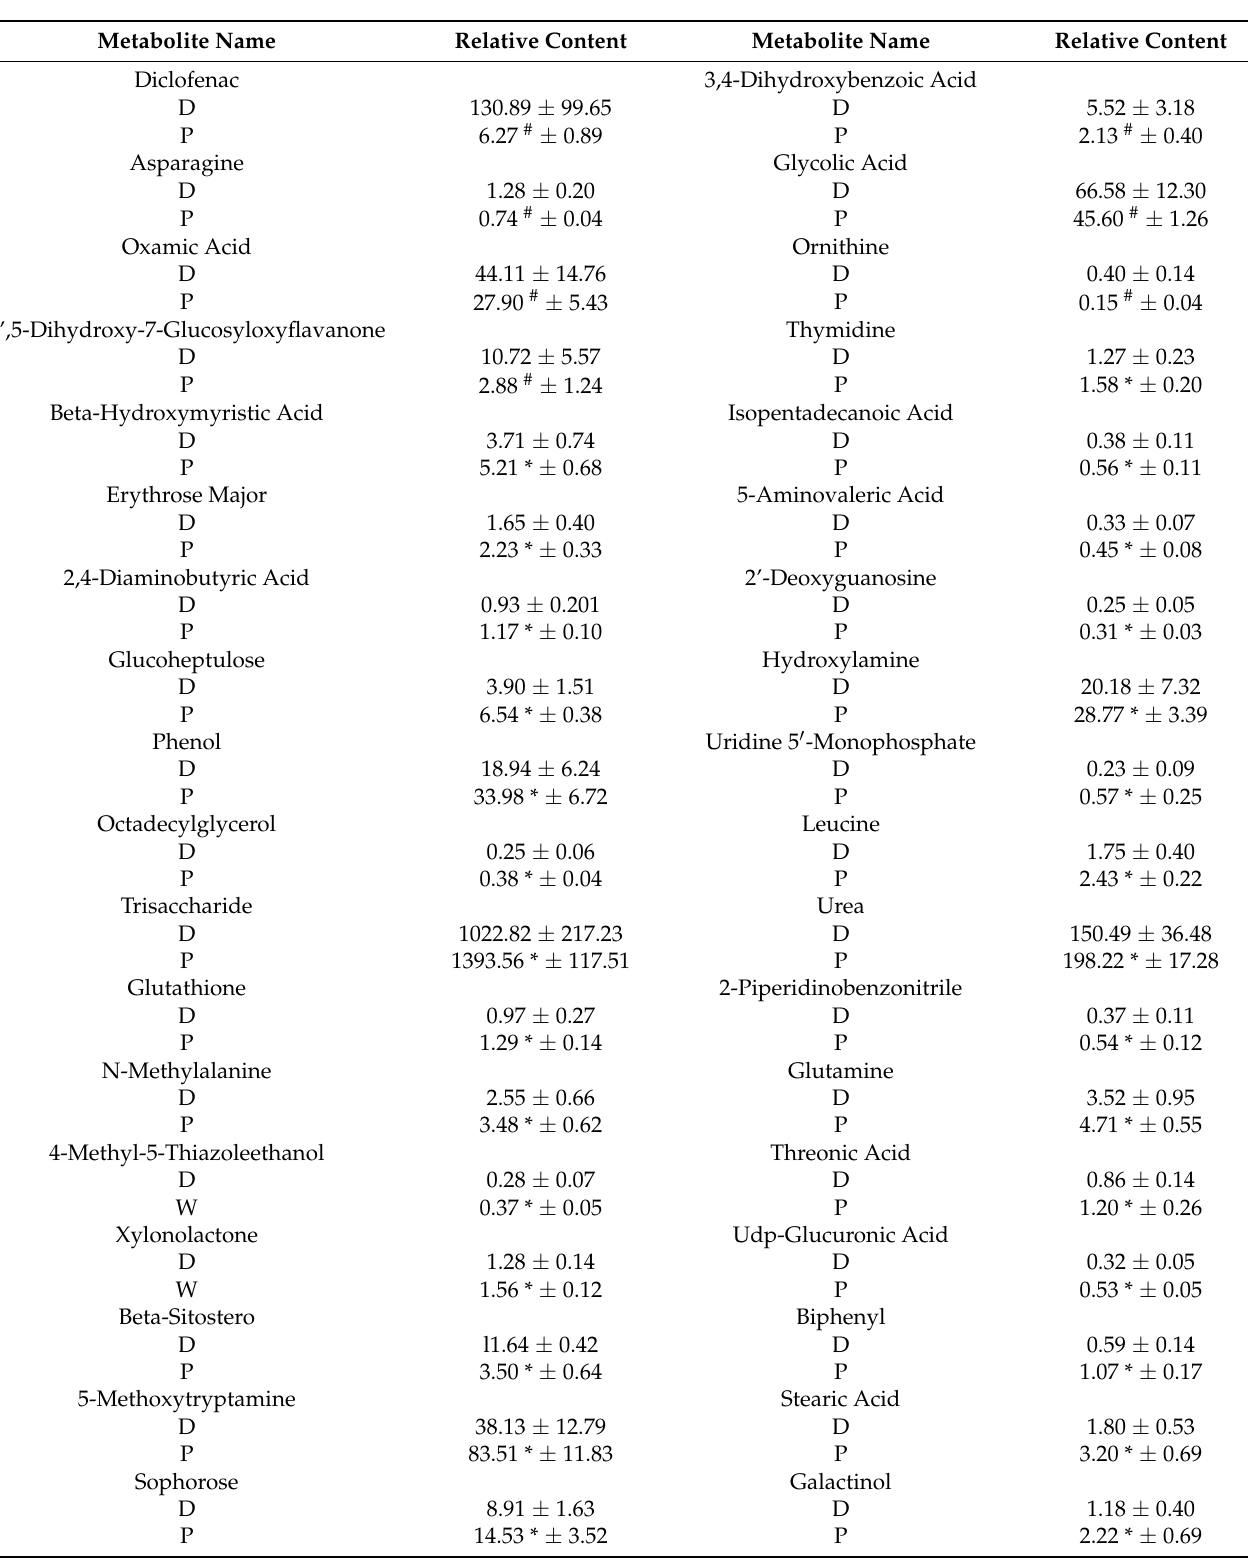
Table 5. The relative contents of the metabolites in rhizosphere soil were changed by prochlora on the decline-diseased